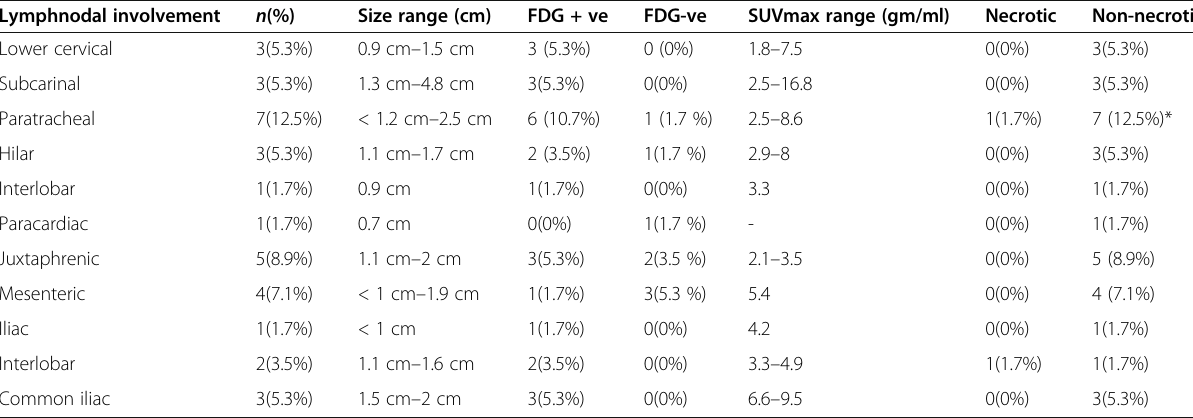
Table 6 Distribution of overall extrahepatic distribution of distant lymphnodal metastases of HCC on FDG PET CT in 56 patients Lymphnodal involvement n